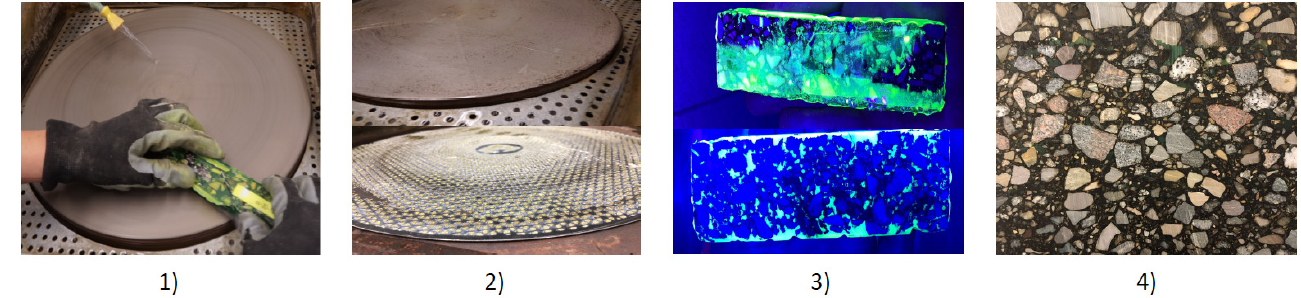
Figure 2. Grinding process of asphalt petrology: ( 1 ) water cooled grinder ( 2 ) different grinding wheels ( 3 ) specimen before and after grinding process ( 4 ) surface of specimen after grinding process (epoxy resin is only left in the voids). [17].